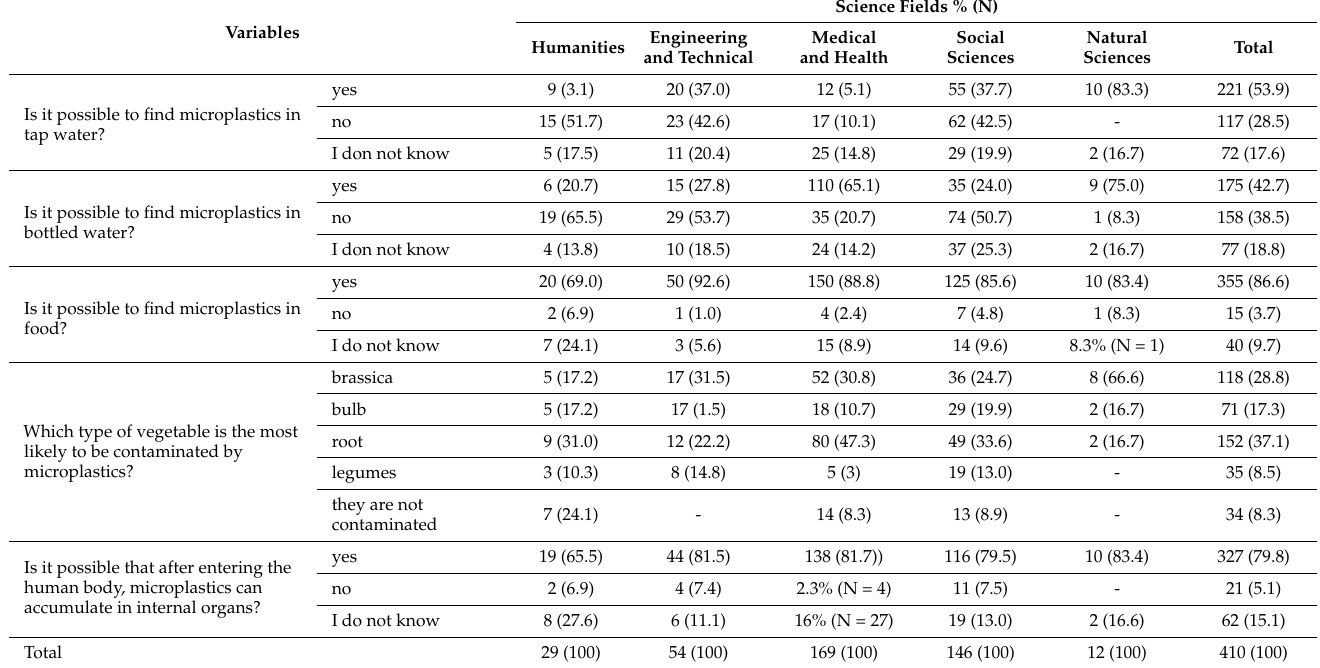
Table 2. The state of respondents’ knowledge about the occurrence of microplastics in water, food, and health effects .